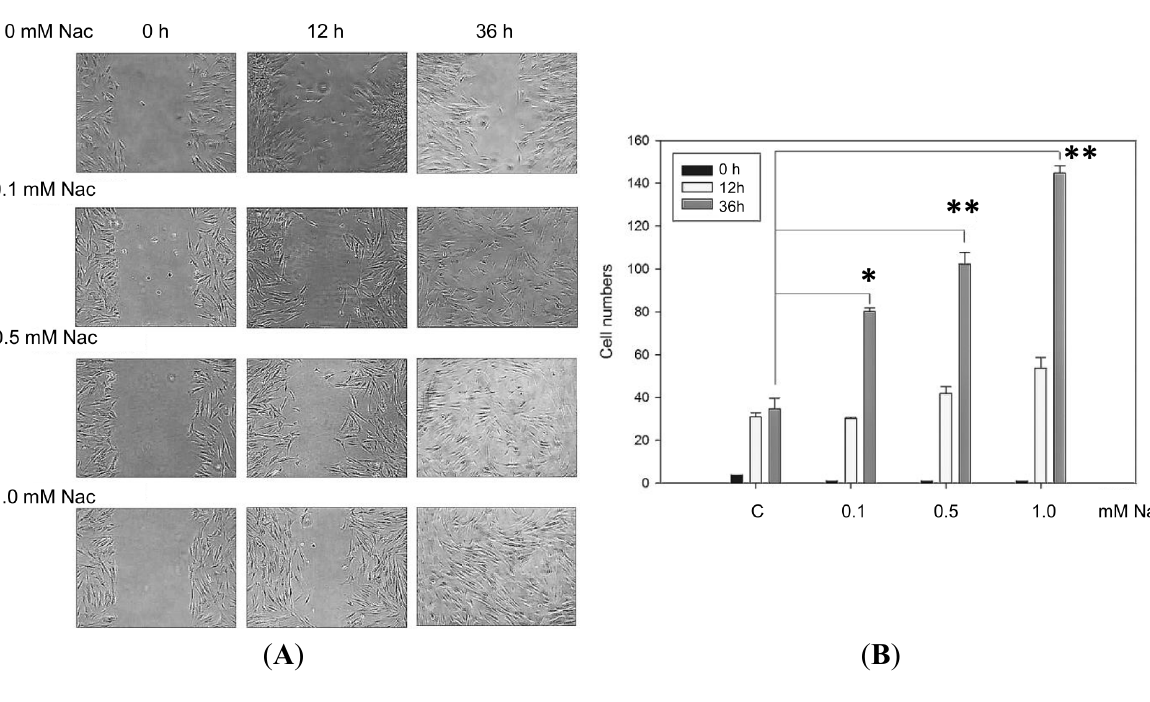
Figure 3. Wound healing analysis of the CCD-966SK cells treated with Nac. ( A ) The treated cells were cultured in a six-well plate after monolayer wounding with a yellow P200 pipette tip. The healing ability was observed using phase contrast microscopy on an inverted microscope after 12 and 36 h; ( B ) Quantitative assessment of the average number of cells in the denuded zone is expressed as the mean ± SD of three independent